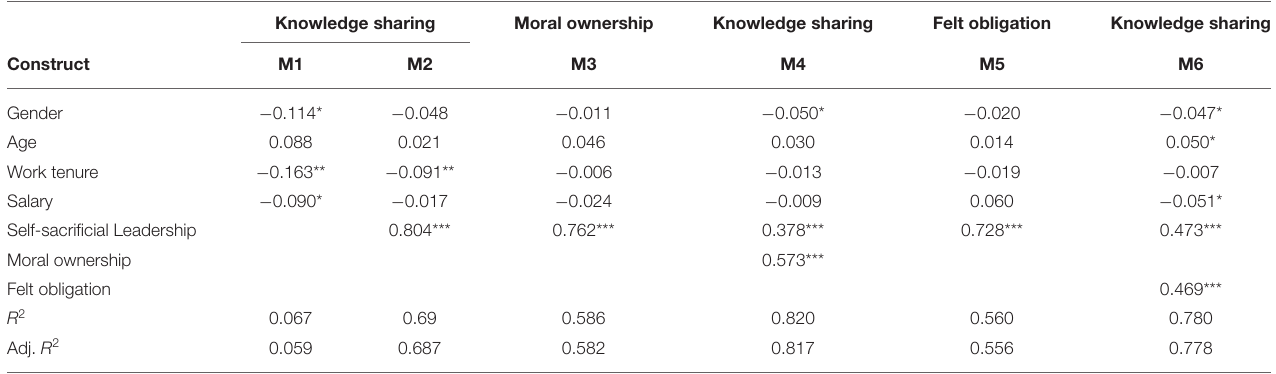
TABLE 3 | Results of direct and mediating effect test.